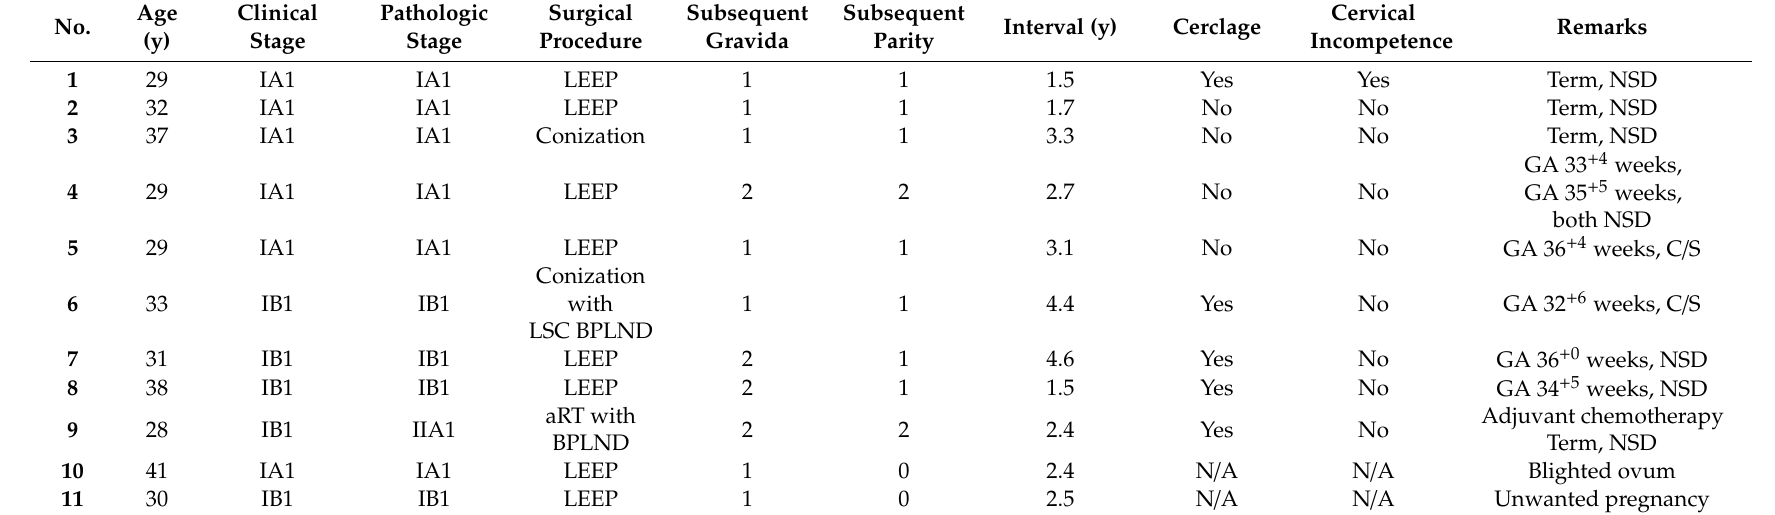
Table 4. Characteristics of the subsequent pregnancies of 11 early-stage invasive cervical cancer patients treated with fertility-sparing surgery. Clinical Pathologic Surgical Subsequent Subsequent No. Interval (y) Cerclage Stage Stage Procedure Gravida Parity